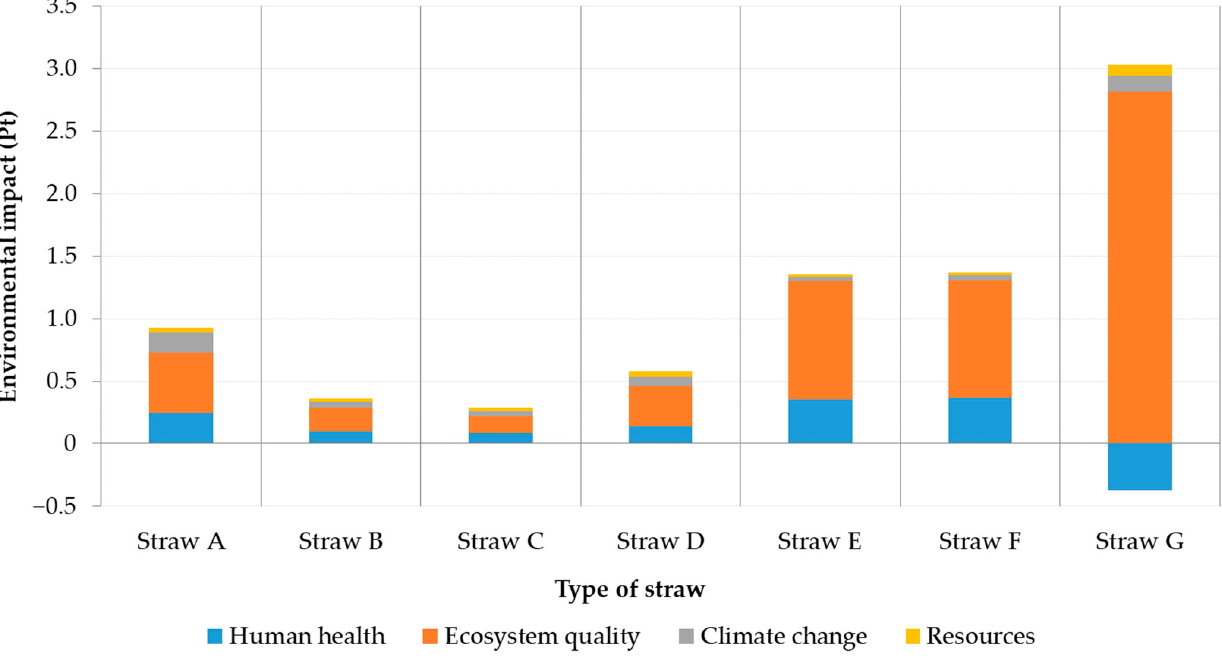
Figure 6. Contribution of different straw alternatives to environmental impact—a single score assessment. Table 5. Relative percentage comparison of individual straw alternatives environmental impact. For each impact category the worst and the best straw alternative was highlighted according to the highest contribution within individual category.